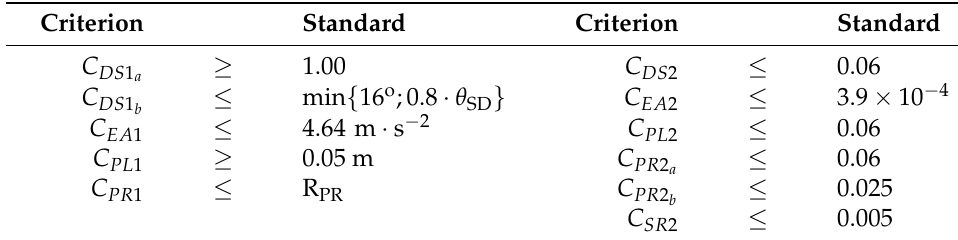
Table 1. Summary of second generation intact stability